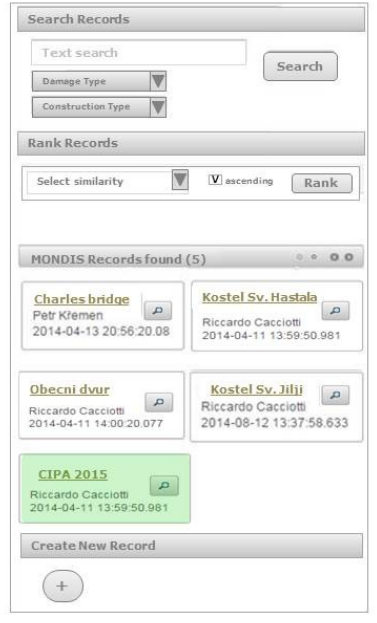
Figure 3. MONDIS explorer: record retrieval section